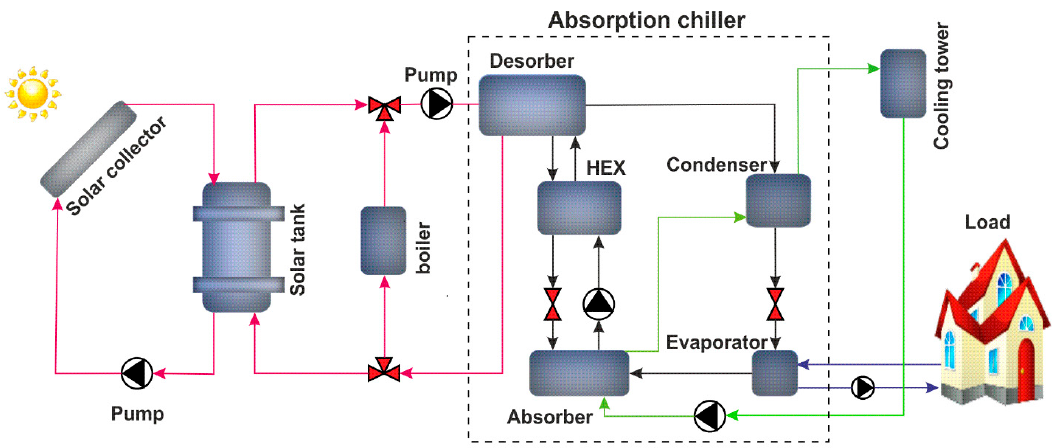
Figure 1. Solar absorption cooling system components.